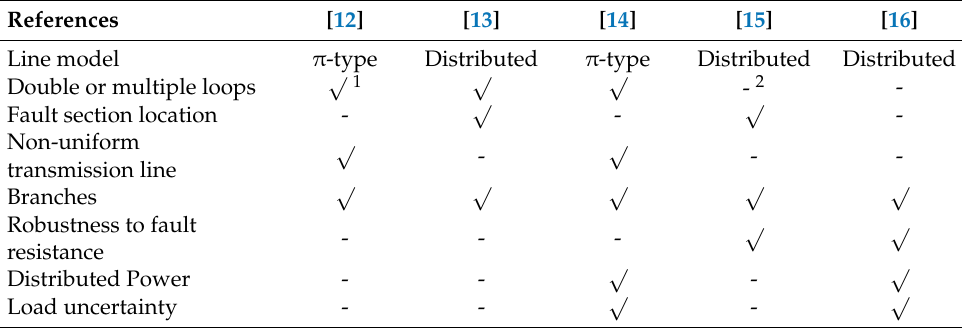
Table 1. The summary of the improvements of the impedance-based